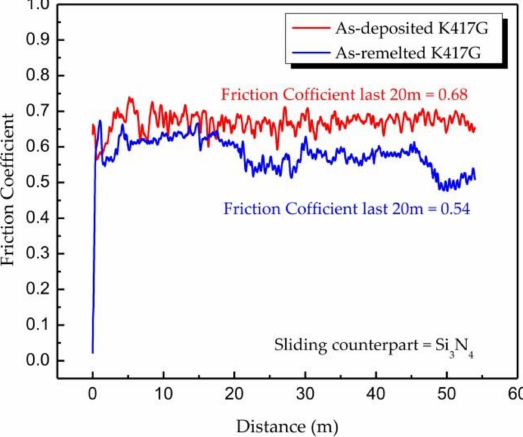
Figure 18. The friction coefficient of the LFRed coatings before and after laser remelting